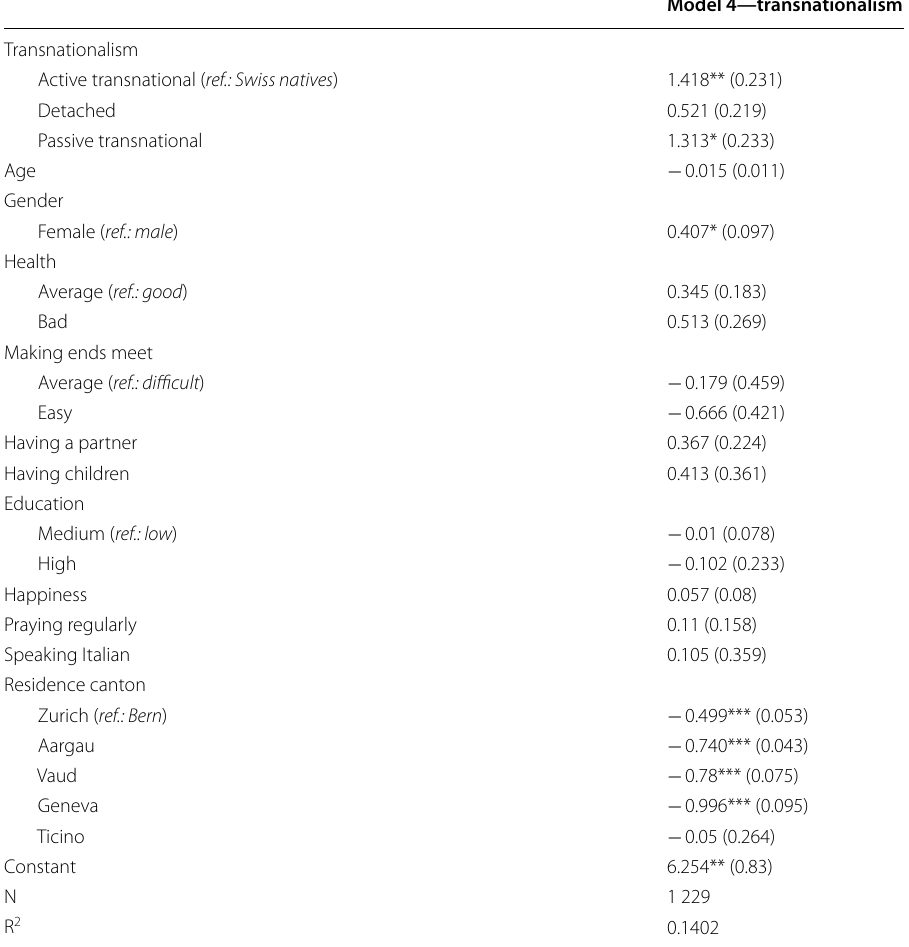
Table 5 Linear regression to test transnationalism on worry about the